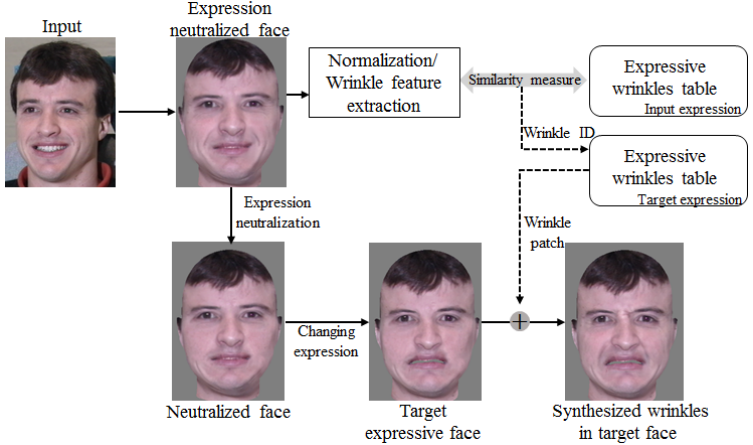
Figure 14. Wrinkle synthesis process on target facial expression